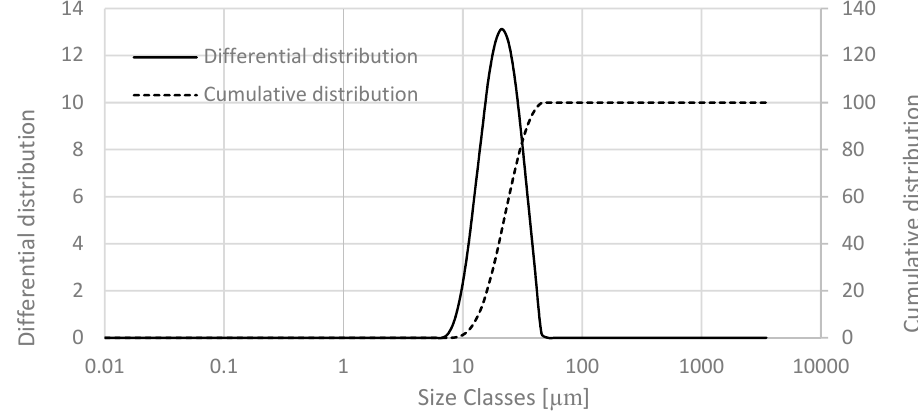
Figure 3. Particle size distribution of prealloyed NiTi powder.